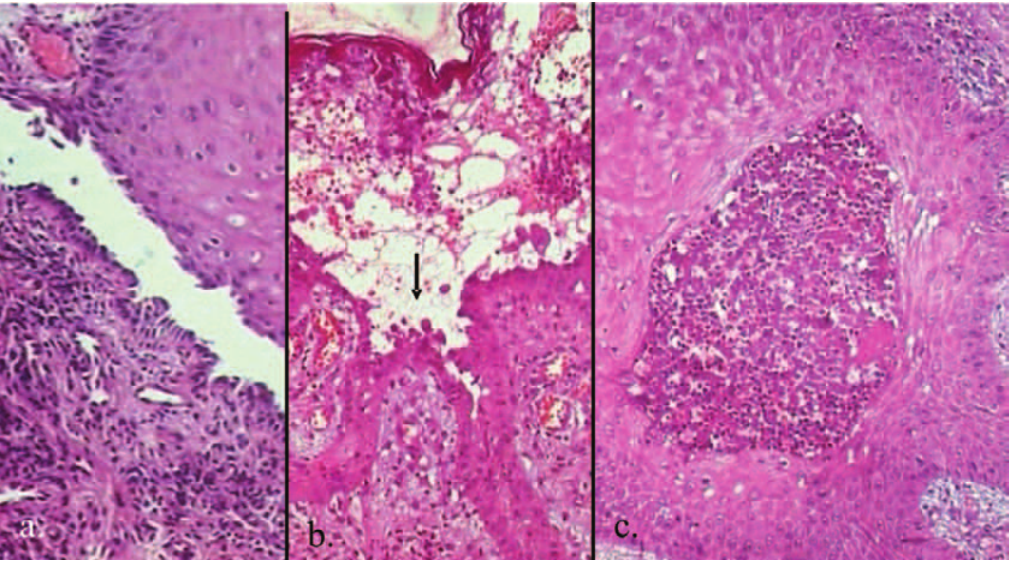
Figure 4 - Light microscopy a. suprabasal cleft in the oral mucosa. b. suprabasal cleft and acantholytic cells (arrow) from a vegetant lesion. c. epithelial hyperplasia with neutrophil abcess from a verrucous acral